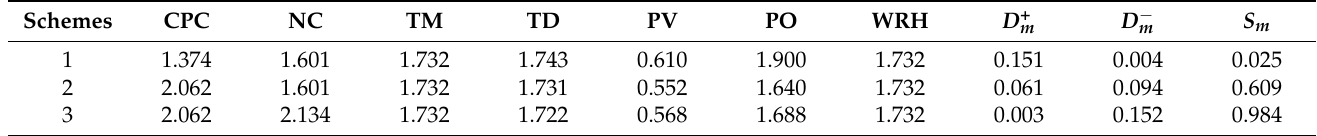
Table 9. Results of the calculations adopting the TOPSIS method for the arch